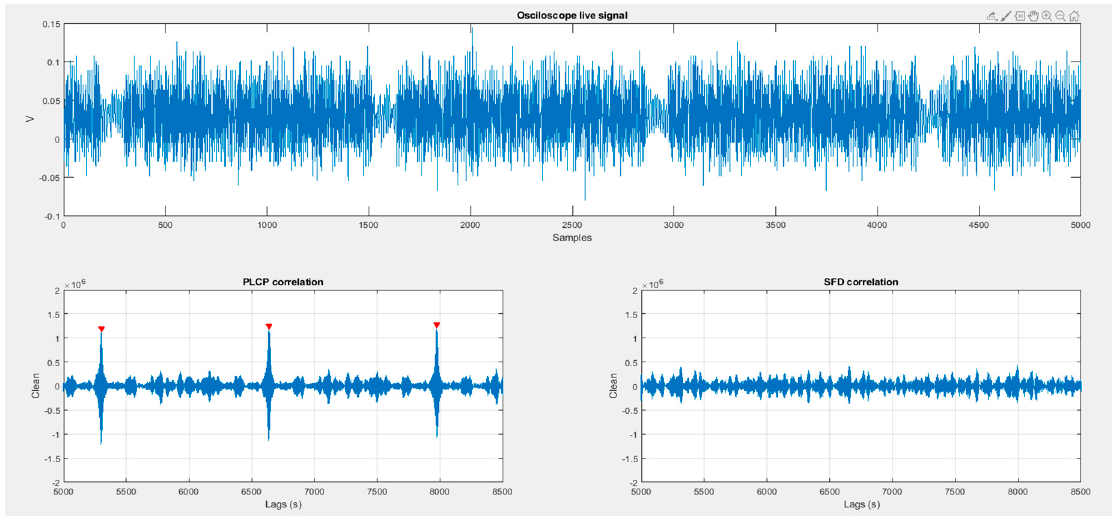
Figure 11. HPC and HPW contact when PLCP id-code is being transmitted.